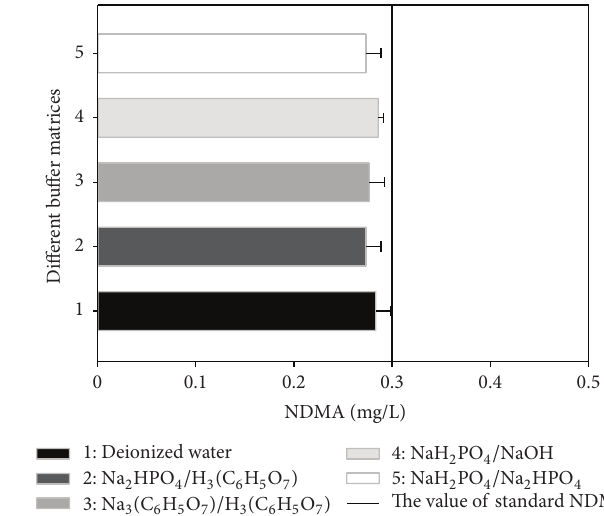
at 90 C in the pH 6.4 phosphate ∘ 2 ). 𝑛𝑛 𝑛 𝑛